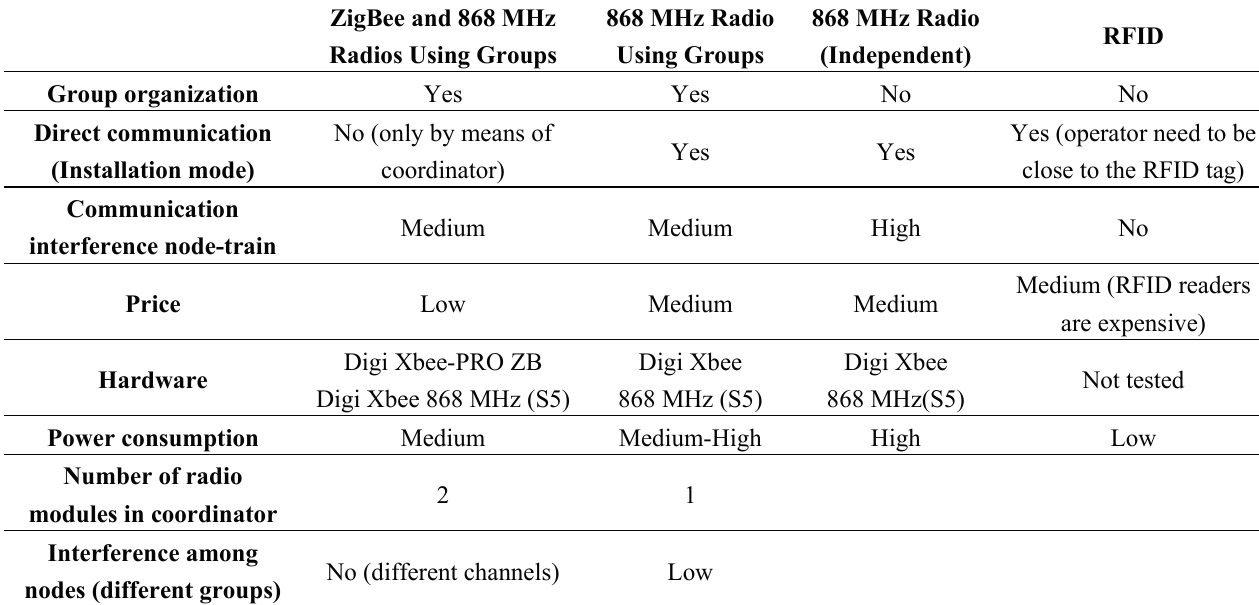
Table 2. Proposed communication